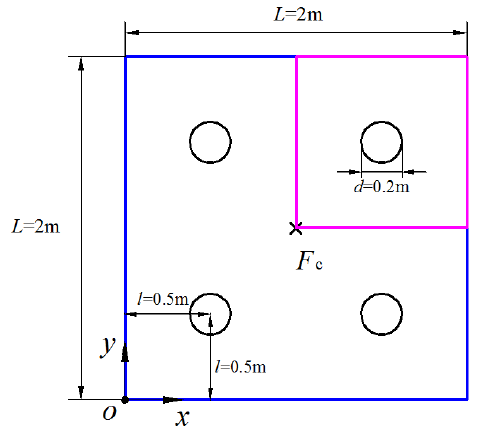
Figure 13. The square membrane with a number of evenly placed holes.